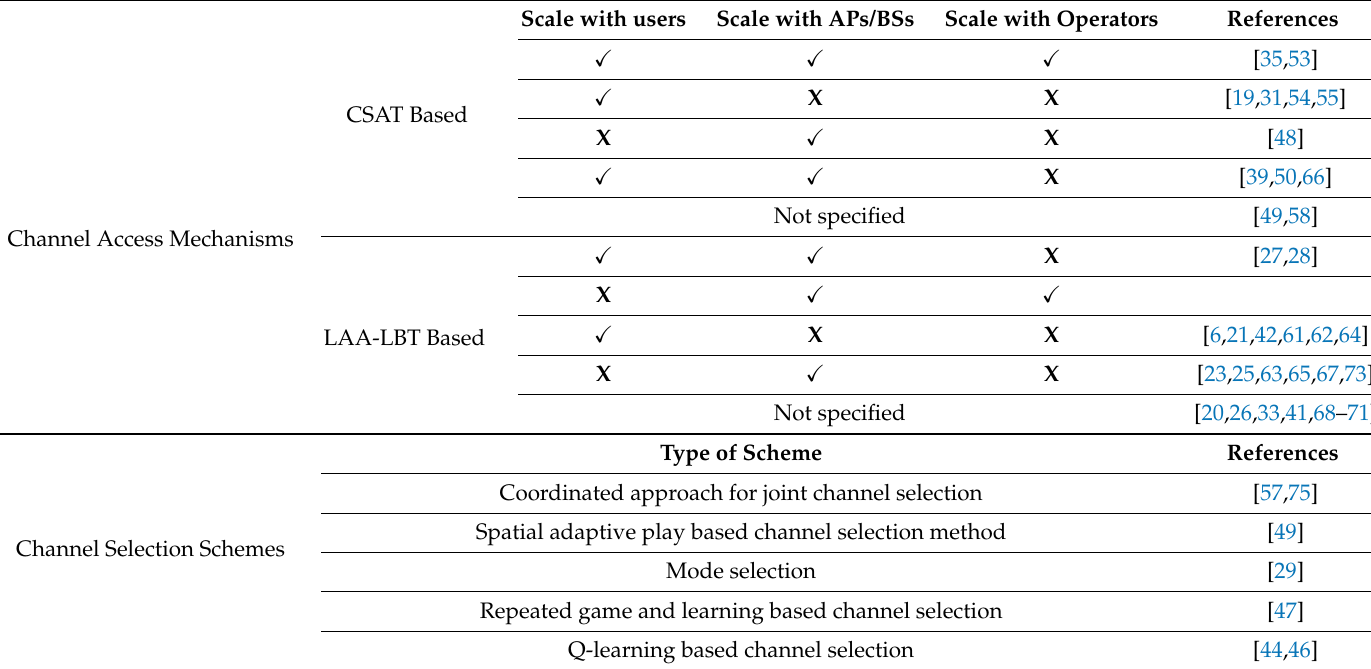
Table 1. A summary of fair co-existence analysis of LTE with WiFi on the unlicensed band.